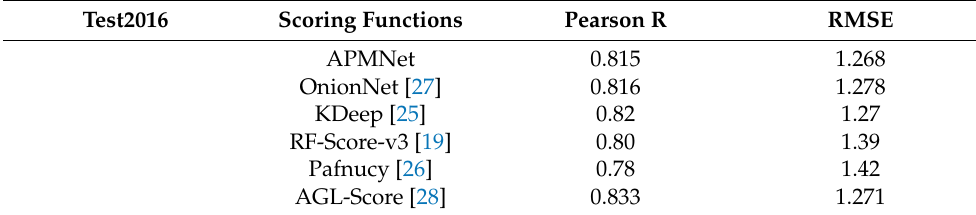
Table 2. Performance Comparison of different methods on Test2016.